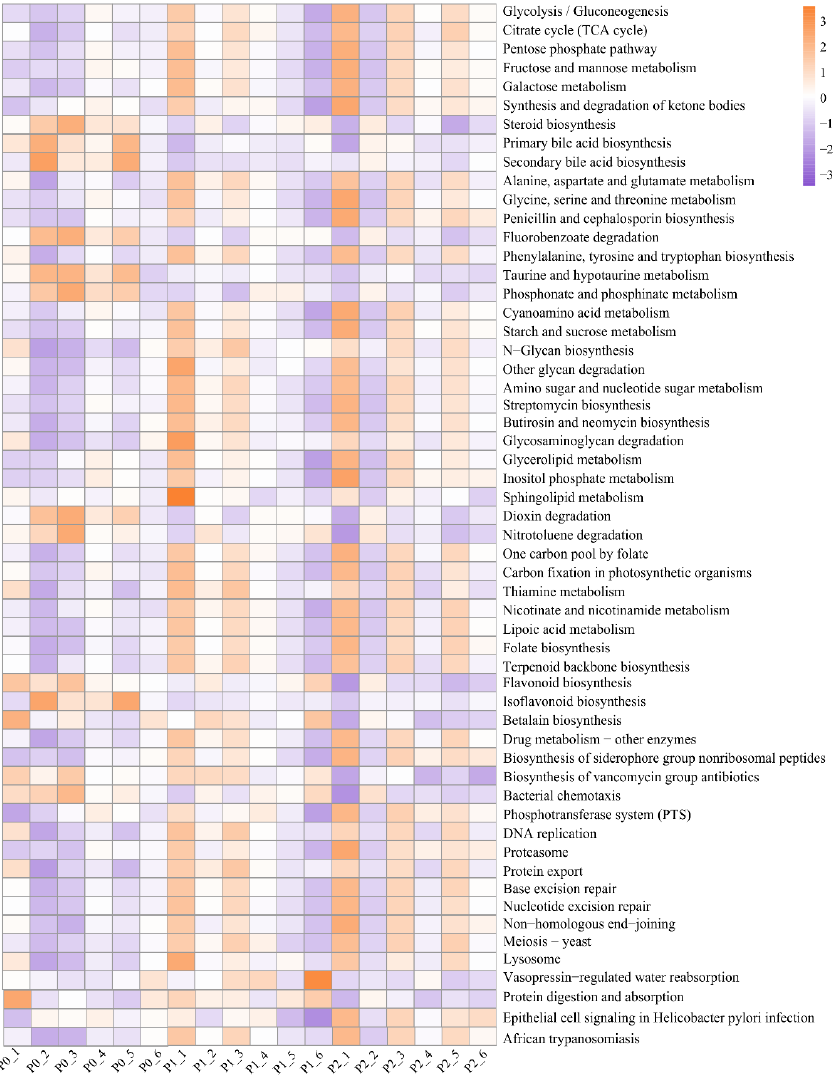
Figure 4. Heat map of bacteria KEGG pathways with significant differences under P input rates ( p < 0.05).